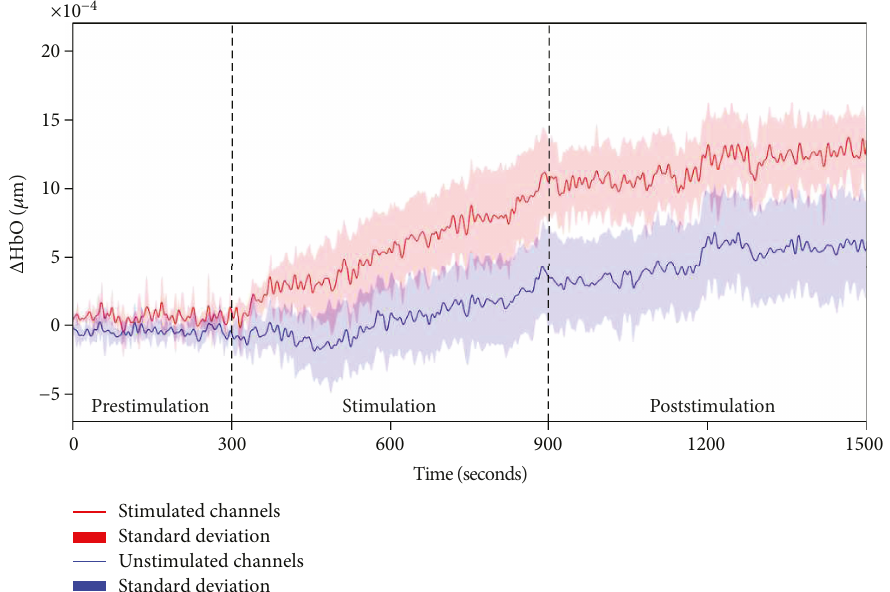
Figure 2: Comparison between stimulated channels (those underneath HD-tDCS) and unstimulated channels ( Δ HbO values were averaged over all